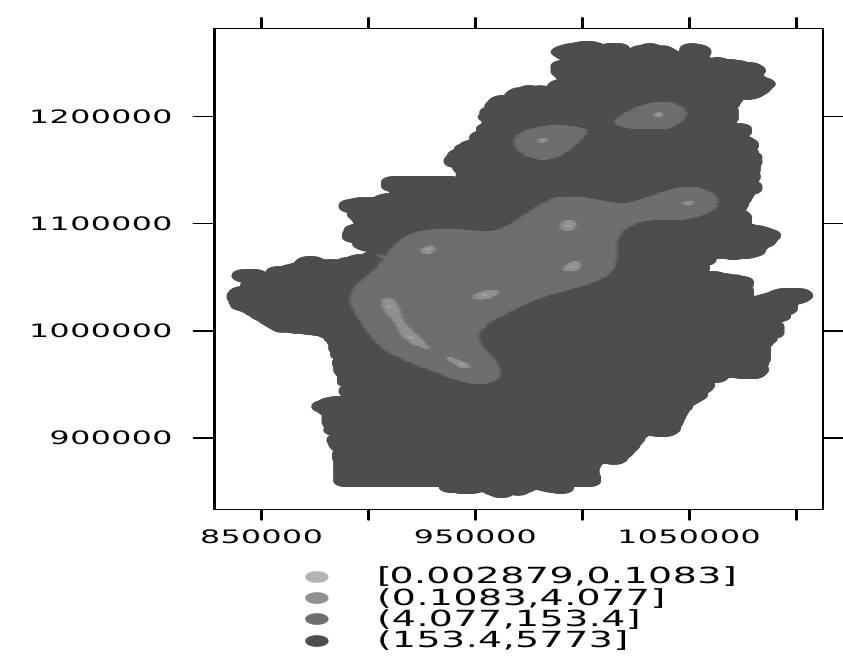
Figure 5. Map of PM10 prediction variances with the highest magnitudes (dark grey) corresponding to zones distant from the sampling